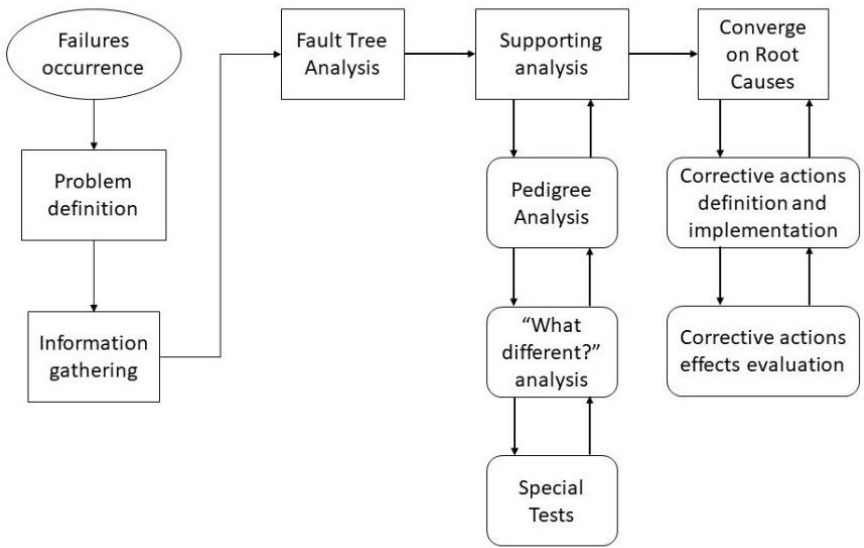
Figure 1. Anomaly analysis process .